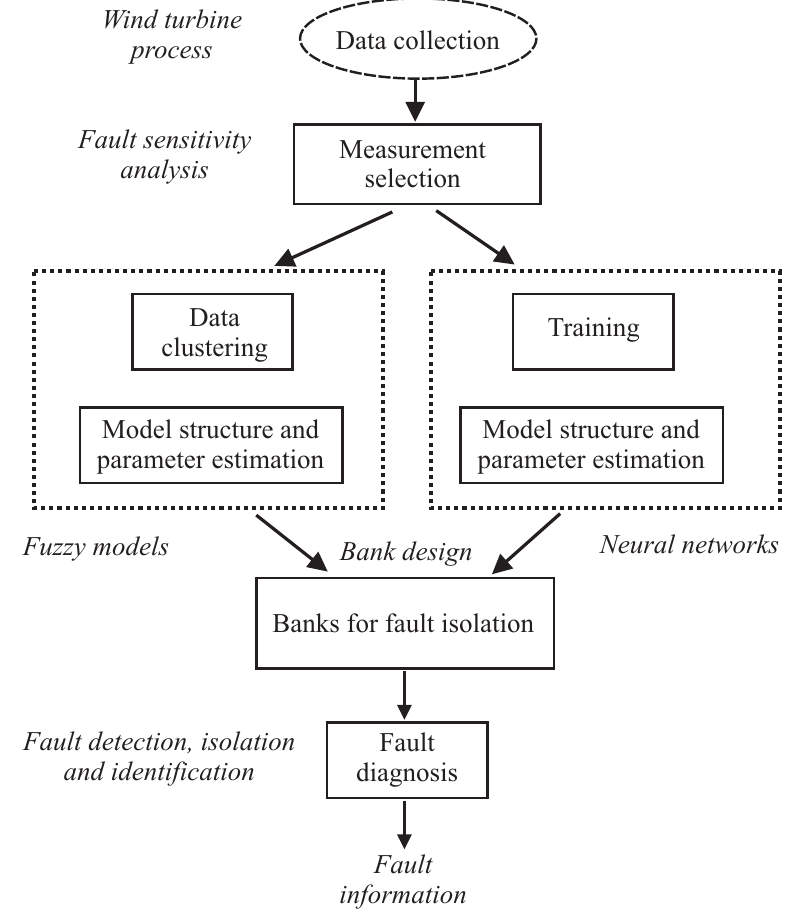
Figure 4. Tasks involved in the design of the proposed FDI